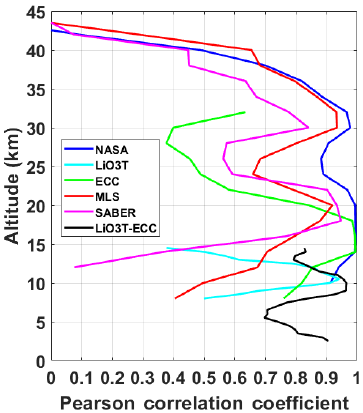
Figure 9. Vertical profiles of the correlation of ozone concentrations measured by the various LAVANDE instruments and ozone concen- tration measured by the LiO 3 S (outliers were excluded). Correlation is taken over the 28 nights of the LAVANDE campaign and over 2km in altitude. Results for MLS and SABER are calculated from the weighted average profiles. Slightly smaller correlations were ob- tained for the closest match SABER or MLS profiles (not shown).